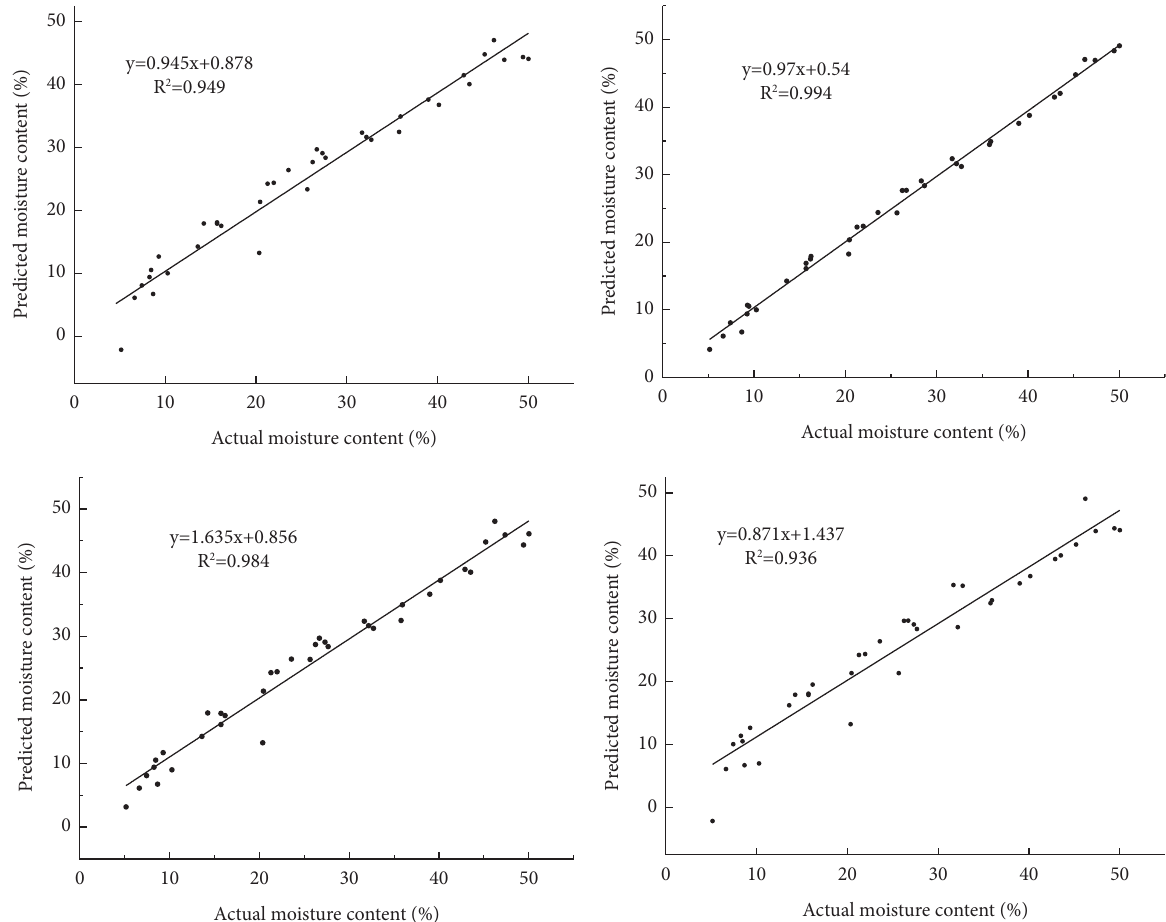
Figure 10: Comparison of predictive model and test set validation